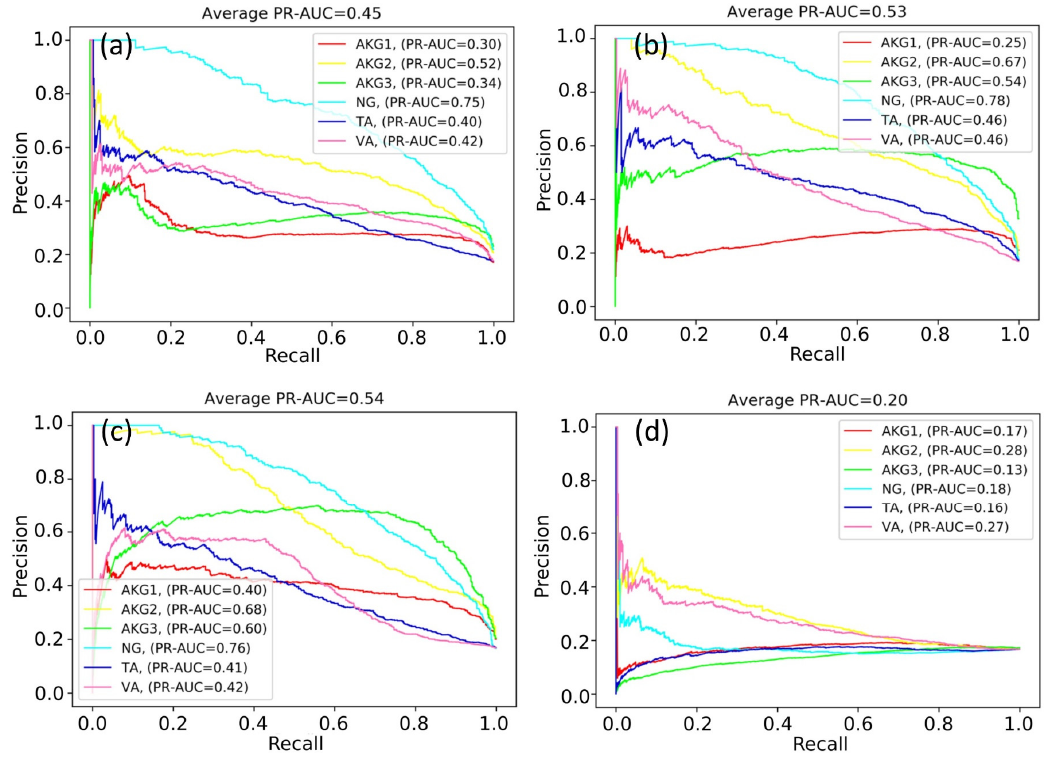
Figure 4. PR curves during neural network training: ( a ) 750 iterations; ( b ) 3000 iterations; ( c ) 5250 iterations; and ( d ) 6750 iterations.